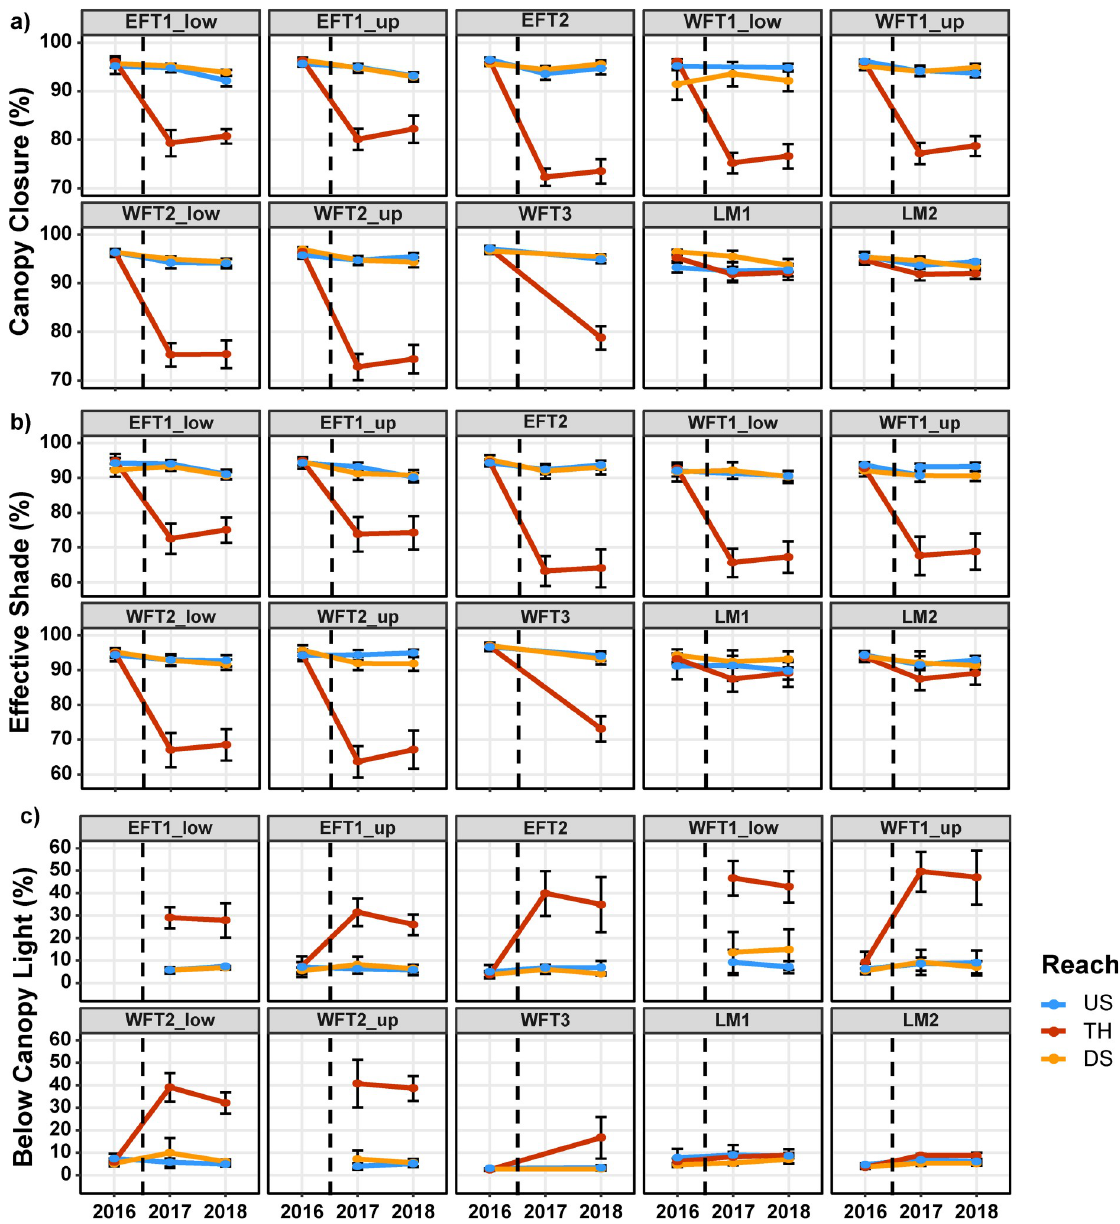
Fig 2. Riparian shade and light responses to riparian thinning. Riparian shade and light responses to riparian thinning in northern California second-growth redwood forests. Riparian shade summarized as a) canopy closure (%), b) effective shade (%), and solar radiation summarized as c) below-canopy light (%) for Tectah and Lost Man sites. Data collected in upstream reference (US), thinned (TH), and downstream (DS) reaches during pre-treatment (2016) and post-treatment years (2017 and 2018) for each site. Points indicate mean estimates with error bars indicating 95% confidence intervals. Vertical hashed line indicates the timing of experimental thinning